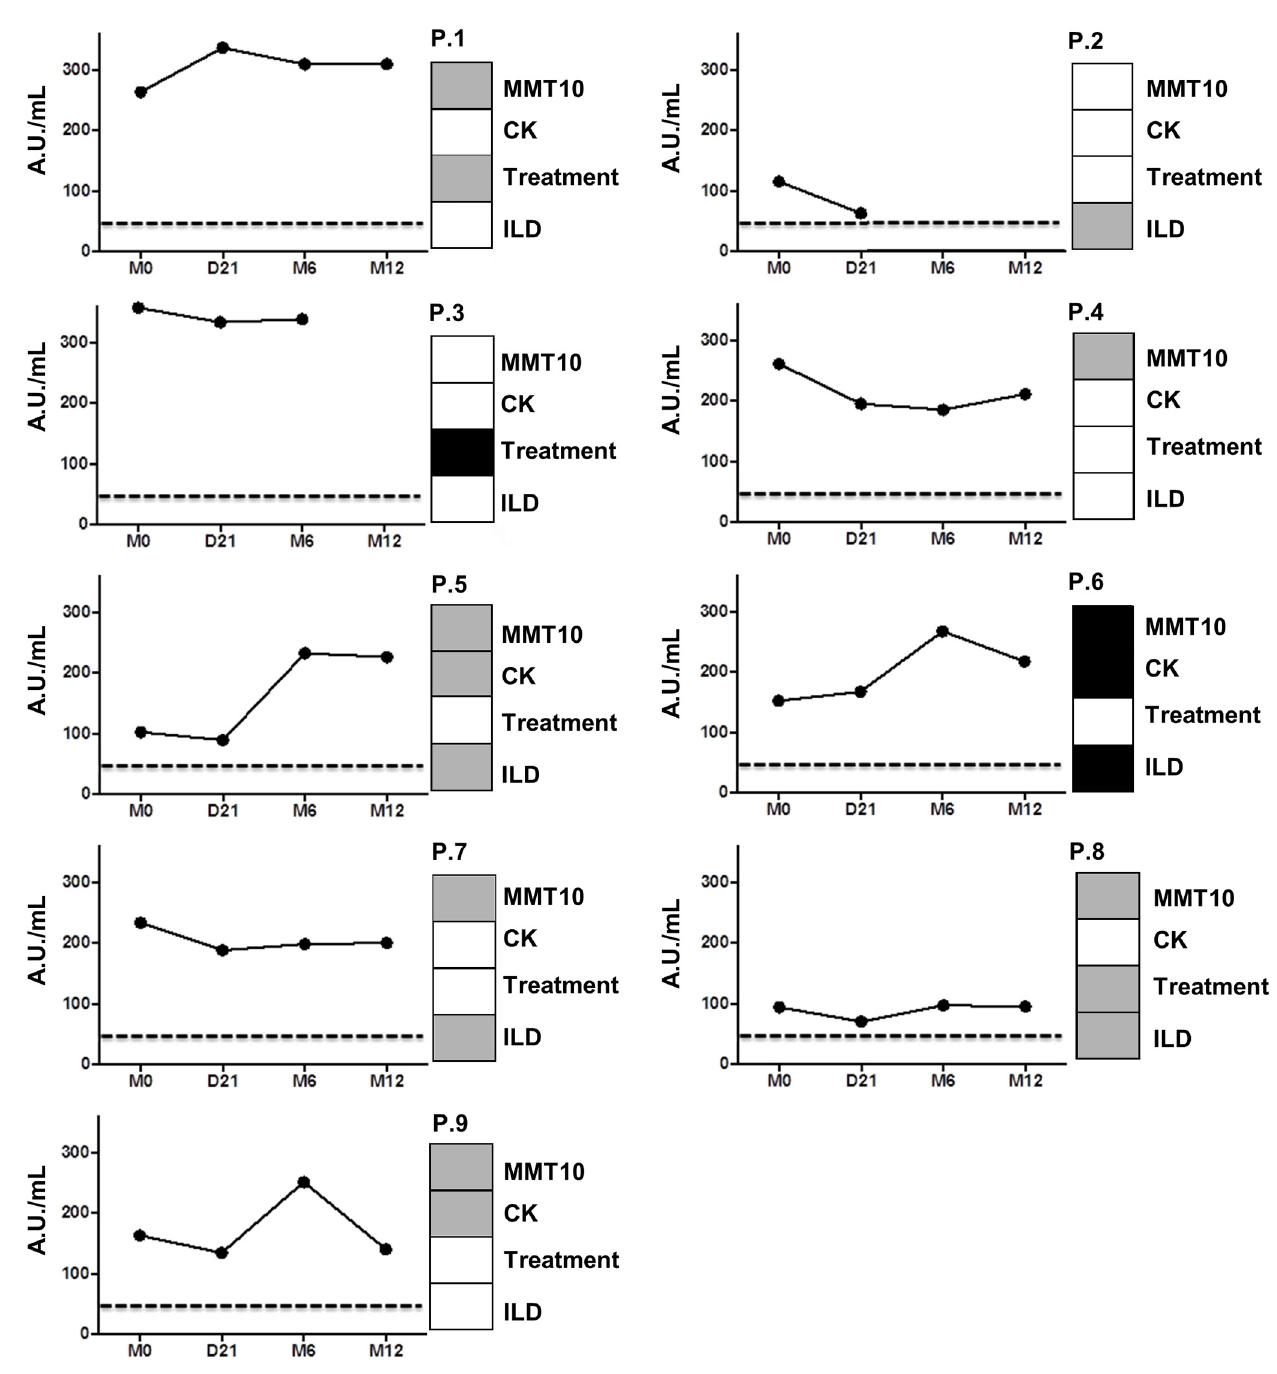
Fig 6. Anti-Jo-1 titer variation and B-lymphocyte depletion. Anti-Jo-1 titer was monitored for the 9 patients who terminated the study (the tenth had anti- PL-7). On the right side, 4 boxes represent the status at M12 (vs M0) concerning manual muscular testing (MM10), creatine kinase level (CK), treatment modification (treatment), and forced vital capacity (FVC). Black represents worsening, grey area represent no change, and white represents an improvement. Concerning CK, black shows an increased level at M12 and white a normal